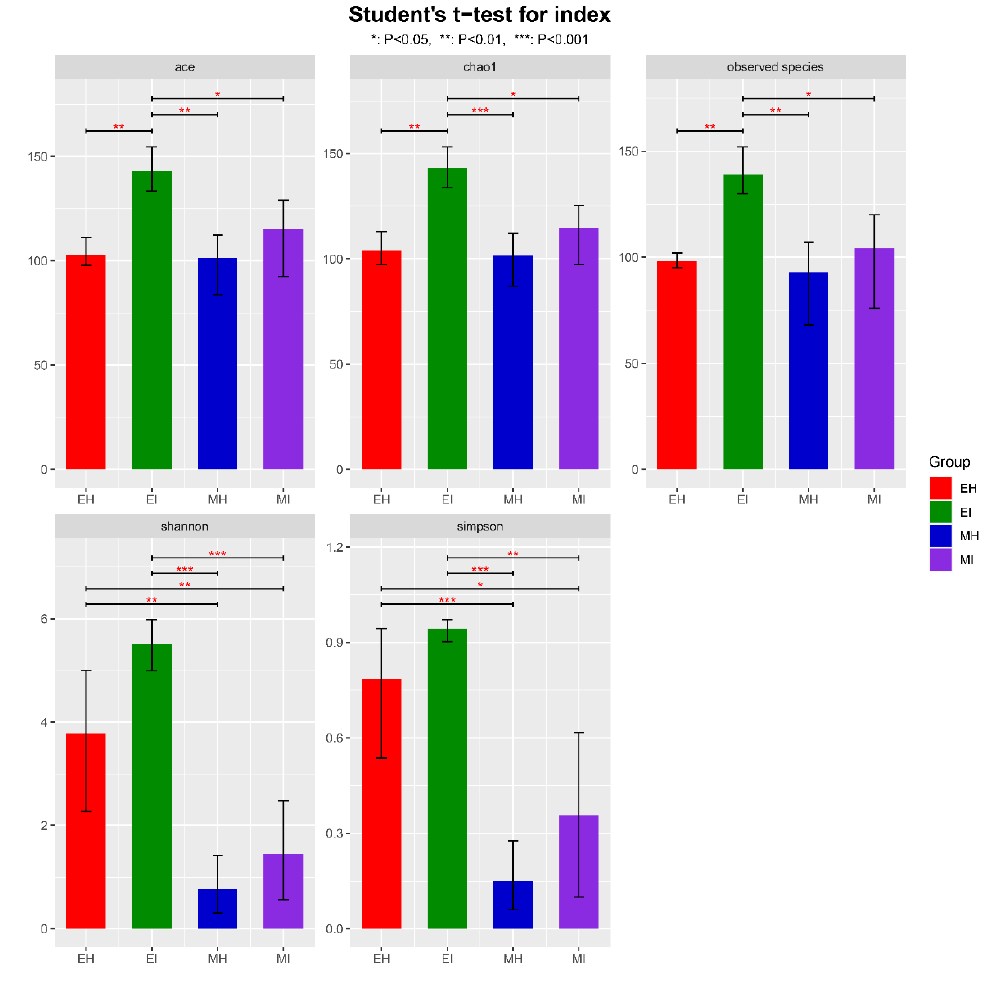
Figure 1. Alpha diversity of bacterial communities in intestinal samples of M. saltuarius . (EH: emergence period, healthy; EI: emergence period, infested; MH: mating period, healthy; MI: mating period, infested. All of these abbreviations apply to the following figures. Student’s t -test; * p < 0.05, ** p < 0.01, *** p < 0.001).